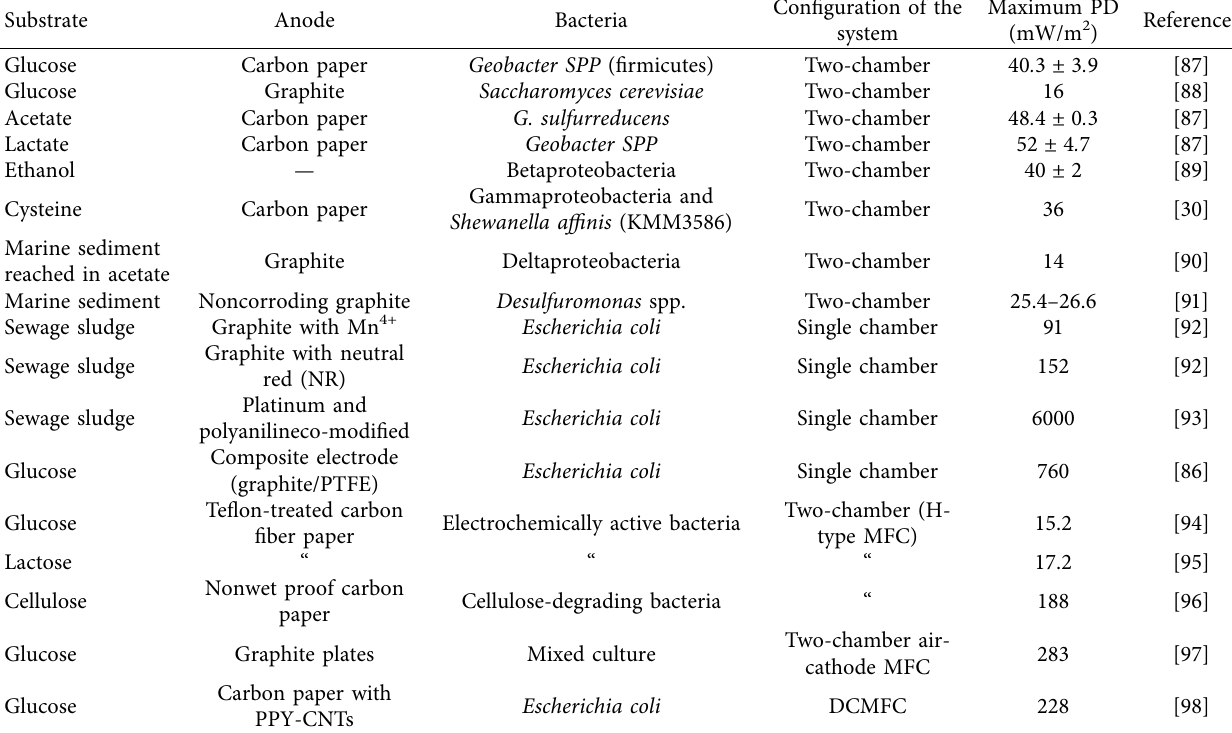
Table 2: Different MFC performances with their respective